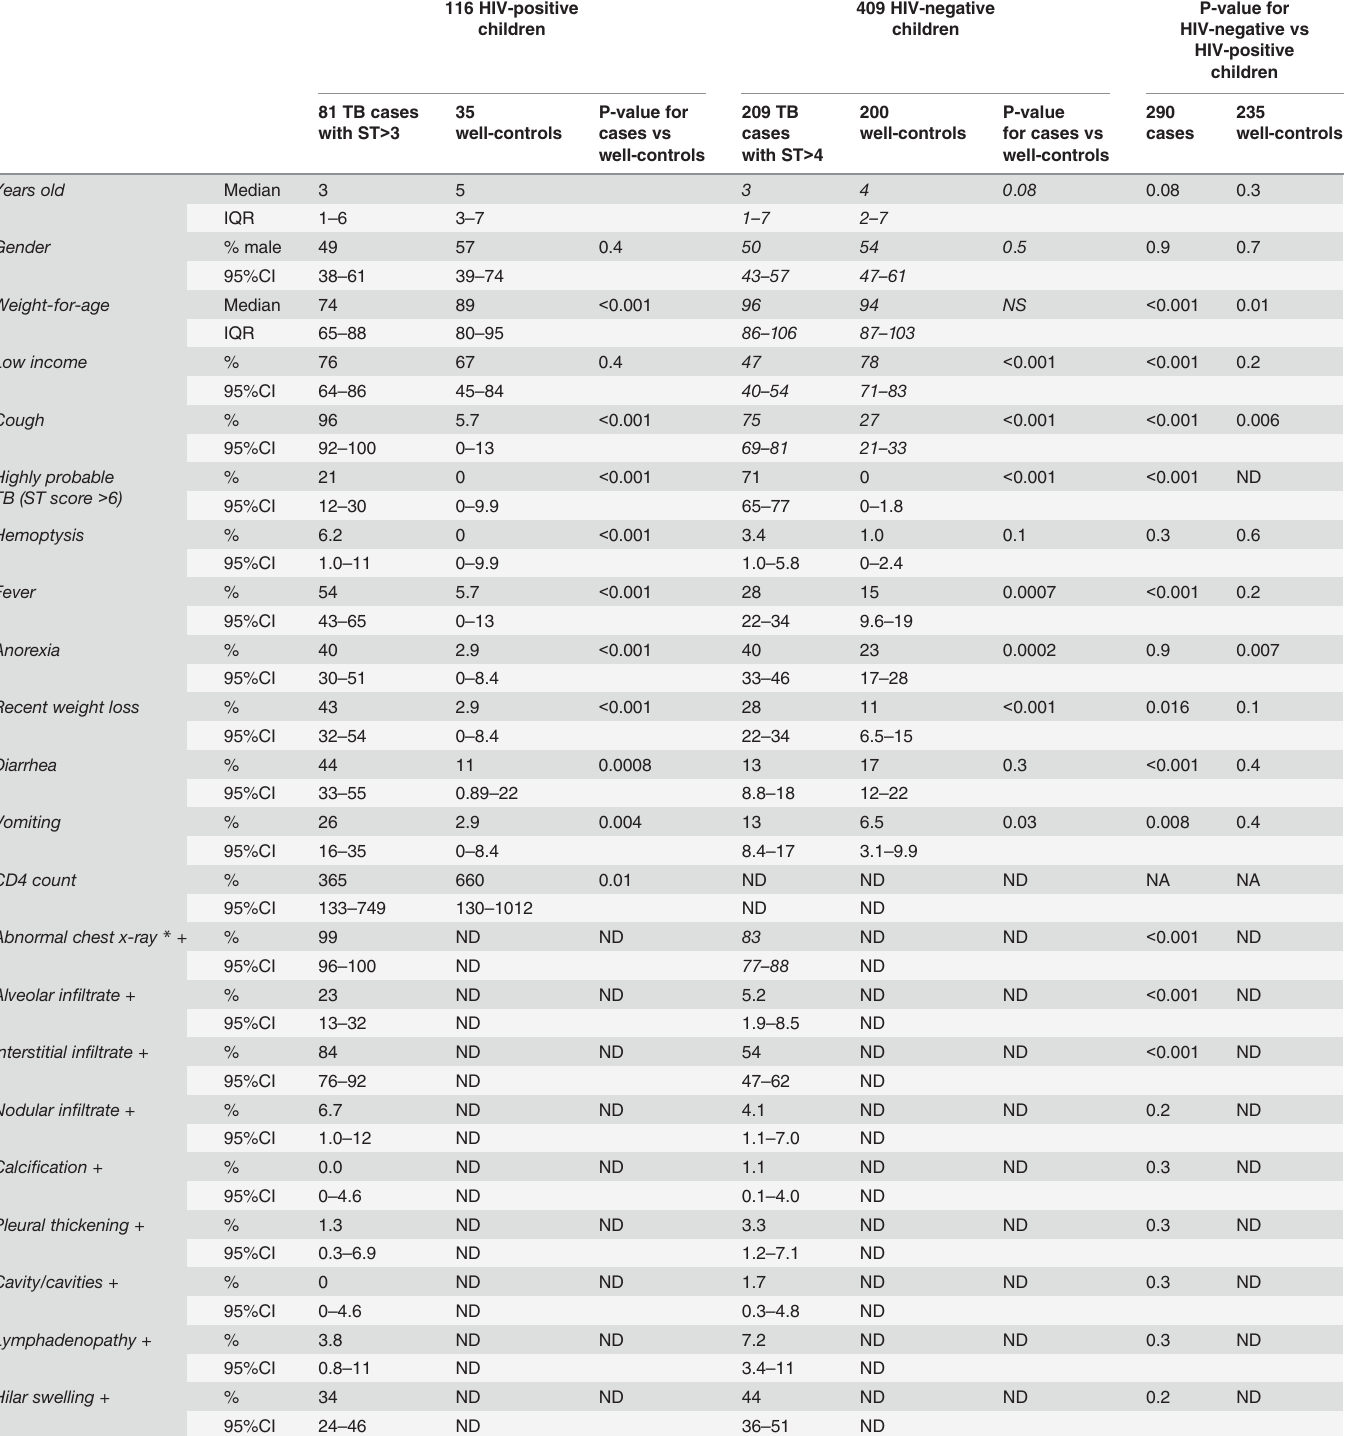
Table 1. Study population demographic and clinical